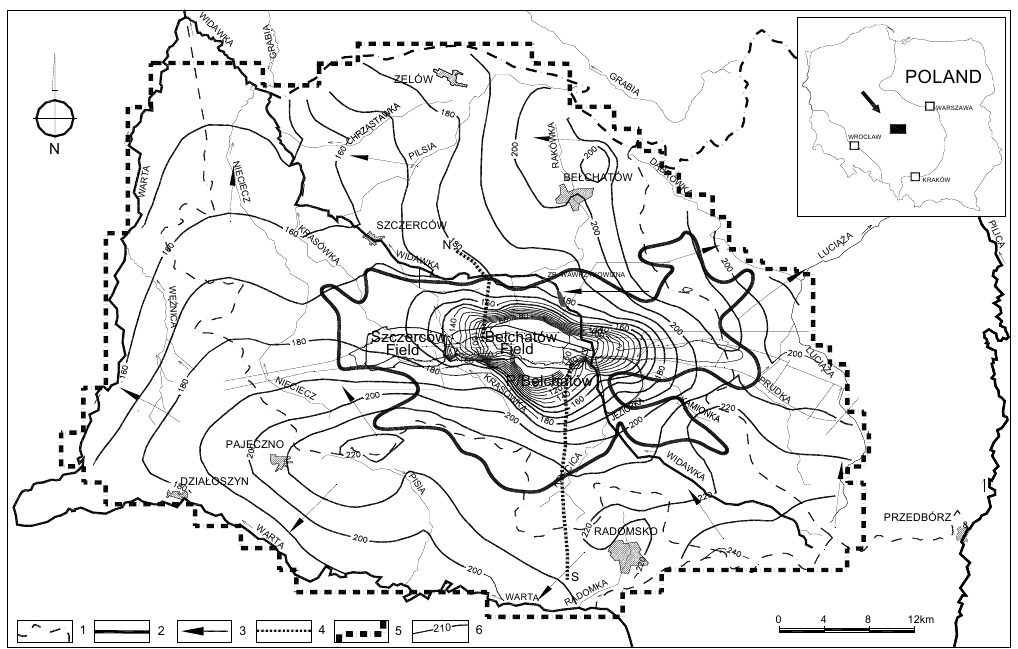
Figure 5. The range of the numerical model in the area of the Bełchat ó w lignite mine with groundwater contours for mining conditions. Explanations: 1 —watersheds; 2 —cone of depression range; 3 —groundwater flow direction; 4 —hydrogeological cross-section; 5 —model boundary; 6 — groundwater level in mining conditions [56].